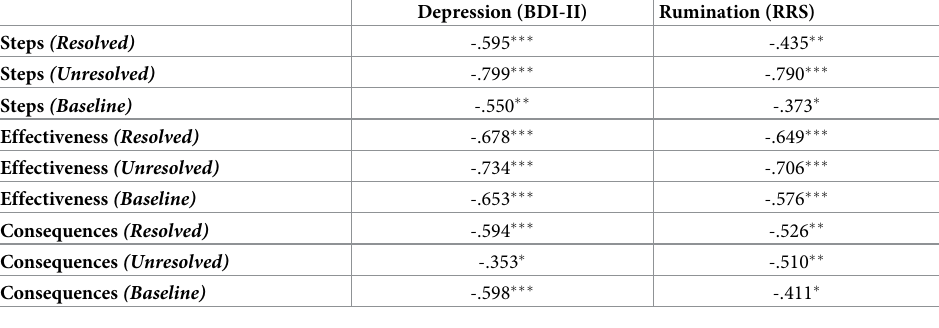
Table 4. Pearson correlation coefficients for depressed participants between recall of consequences, social prob- lem-solving and self-reported depression and rumination